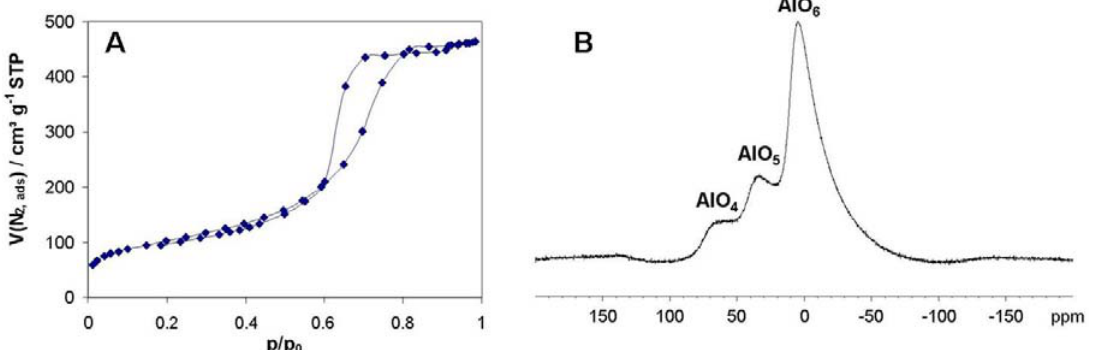
Figure 7. ( A ) Typical N sorption isotherm at 77 K for alumina monoliths and ( B ) 27 Al 2 MAS NMR spectra recorded at a steady spin rate of 10 kHz of an alumina monolith (Al/PEO = 1/5.1 × 10 − 6